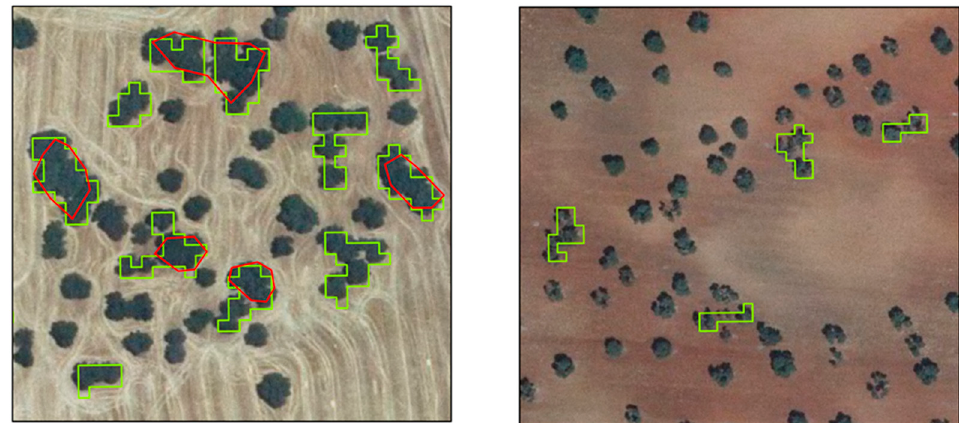
Figure 11. Errors of commission in the classification of copses.